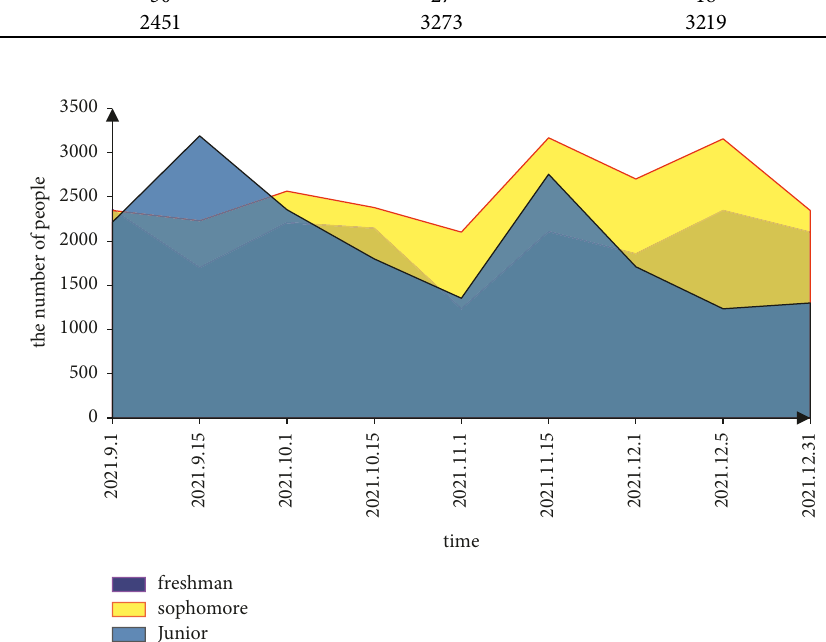
Figure 7: Usage of smart cloud